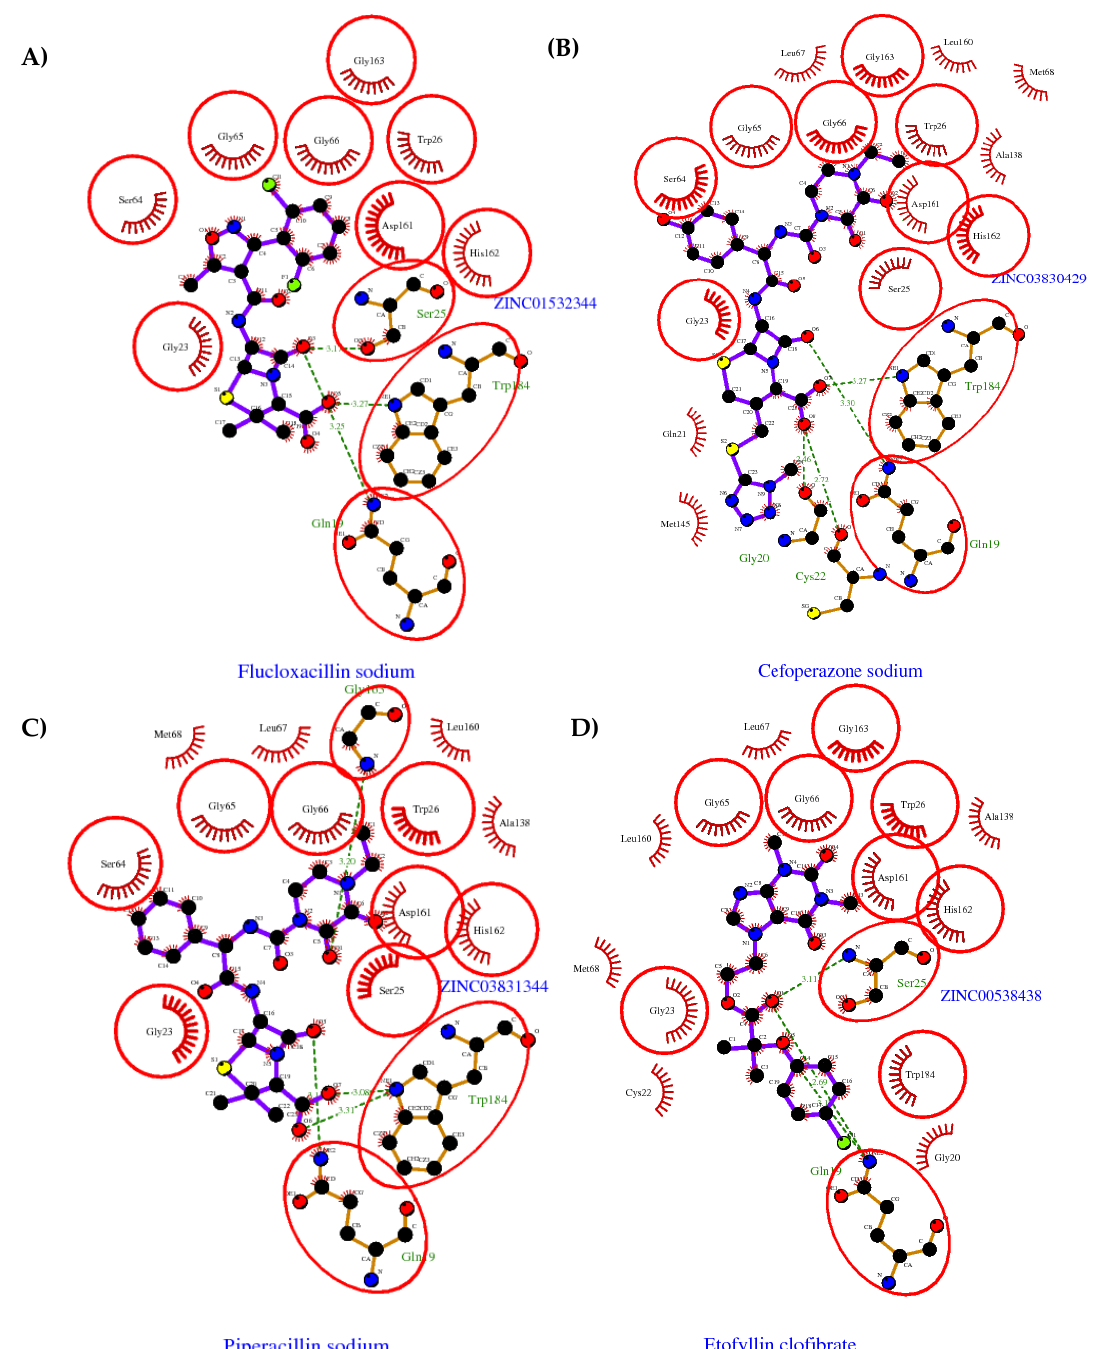
Figure 3. The four selected compounds docked in the 4W5B Cz active sites. ( A ) Flucloxacillin sodium, ( B ) Cefoperazone sodium, ( C ) Piperacillin sodium, ( D ) Etofyllin clofibrate. In the four figures arcs with red lines represent amino acid hydrophobic contacts, green dashed lines represent hydrogen bonds, the red circles represent the shared amino acids. The image was produced with LigPlot software [17].